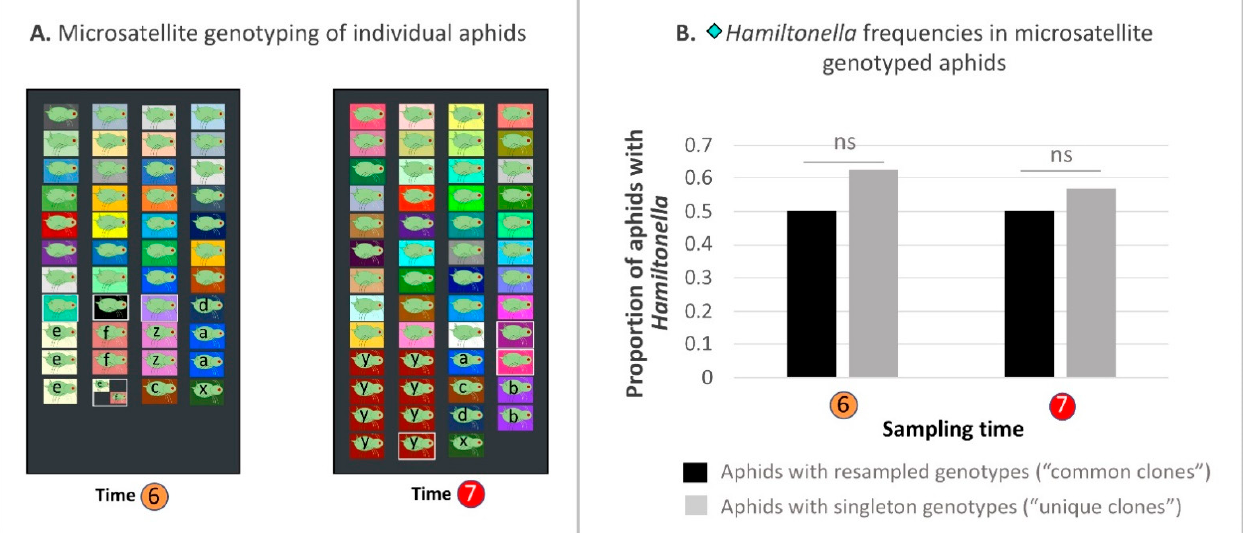
Figure 6. No evidence for Hamiltonella hitchhiking with favored aphid clones at times 6–7 during our 2012 field season. Anal- yses performed to further assess whether Hamiltonella ’s rise in frequency during a hot time period (times 6–7; Smith et al., 2021 [60]) was a product of hitchhiking. In brief, genotyping of pea aphids at six microsatellite loci provided no support for selection on common aphid clones with incidentally high Hamiltonella infection rates. ( A ) Infographic gives a unique color to each unique genotype for the n = 44 and n = 51 microsatellite-genotyped aphids from times 6 and 7. Aphids with resampled genotypes are labeled with letters (a, b, c, d, e, f, x, y, z). Boxes outlined in white represent aphids with only 5 genotyped loci. For these aphids we inferred a plausible 6-locus genotype assignment by declaring the aphid to most likely encode a singleton genotype (i.e., if it was not identical to any one aphid at all 5 of its genotyped loci) or to more likely belong to a resampled genotype/clone (i.e., if it was identical to one or more resampled genotypes at all 5 of its genotyped loci). For one aphid (Time 6), the genotype appeared equally likely to assign to genotype/clone “e” or “f”. ( B ) Frequencies of Hamiltonella in microsatellite genotyped aphids from times 6–7. If selection was operating on common clones with high propensities for Hamiltonella infection one would expect aphids with resampled genotypes to have a higher prevalence of Hamiltonella than those with unique genotypes. Yet, Fisher’s Exact Test statistics revealed that they did not ( p > 0.05 for the comparisons at each time, indicated with the “n.s.” abbreviation, for not